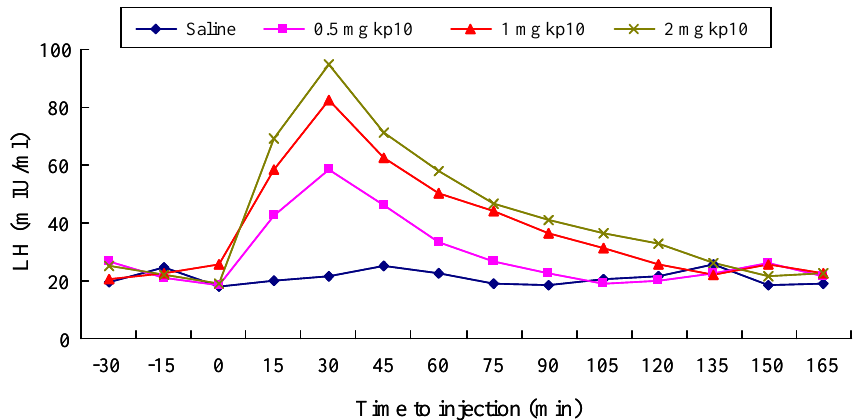
Figure 1. Changes in the serum concentrations of LH over 180 min in prepubertal ewes that received intravenous injection of 0, 0.5, 1 and 2 mg kisspeptin-10 (kp10) dissolved in 5 ml of saline at 0 min.